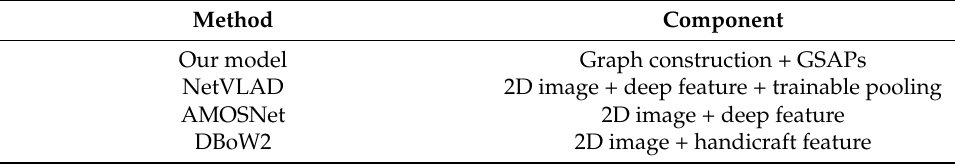
Figure 6. The Precision–Recall Curve comparison of the VPR models in subsequences “Night”, “Summer”, and “Fog” of SYNTHIA dataset. Table 3. The comparison and component analysis of the VPR